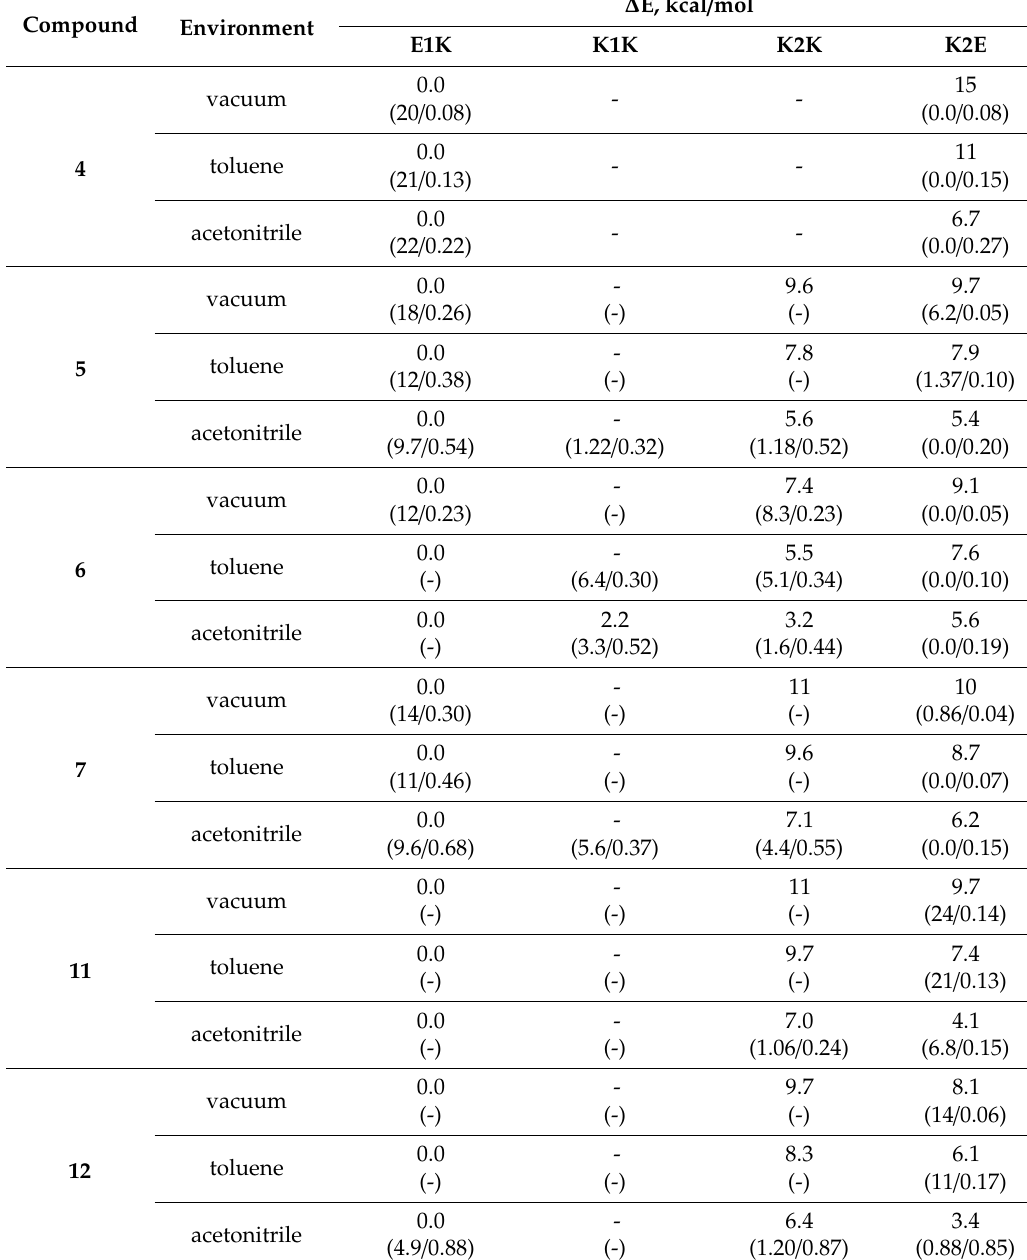
Table 1. Relative energies of the tautomers of 4 – 7 and 11 – 12 in ground and excited S 1 (in brackets together with the corresponding oscillator strength)